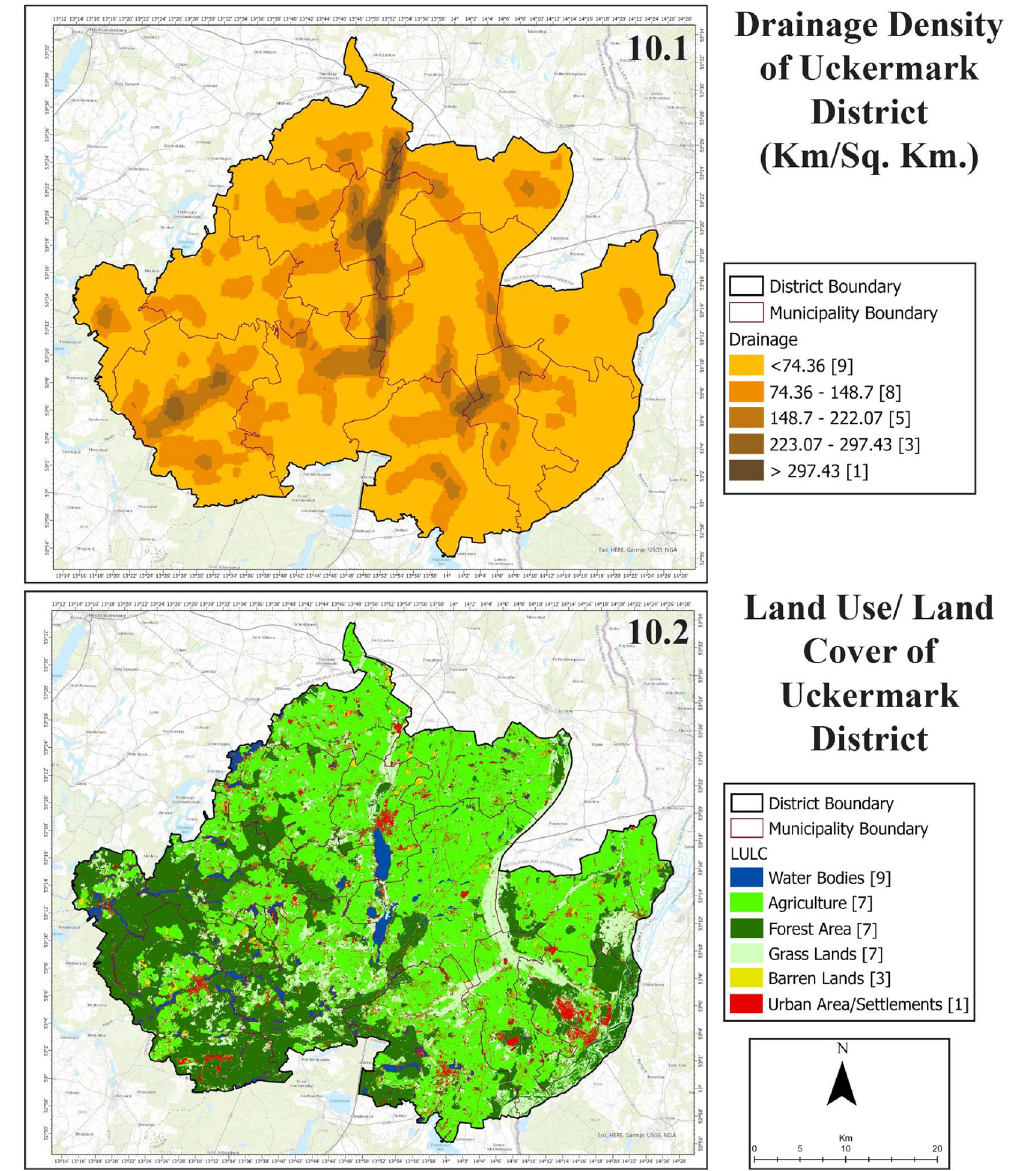
Figure 10. Drainage density (10.1) and LULC (10.2) of Uckermark